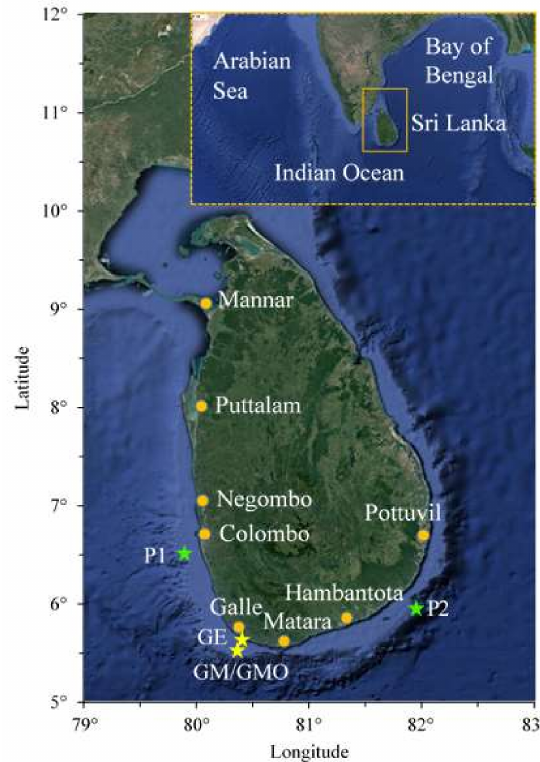
Figure 1. Map of Sri Lanka and its location in the Indian Ocean. Major towns referred in the text are marked in yellow dots. Wave model validation points are marked in stars [GMO-(5.931 ◦ N 80.232 ◦ E); GE-(6 ◦ N 80.25 ◦ E); GM-(5.93 ◦ N 80.23 ◦ E); P1-(6.750 ◦ N, 79.750 ◦ E); P2-(6.250 ◦ N, 81.750 ◦